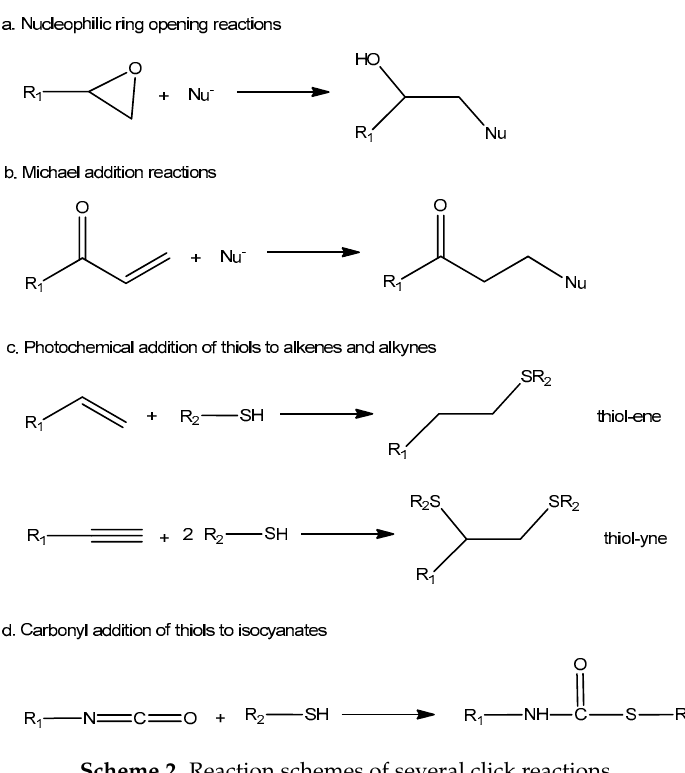
Scheme 2. Reaction schemes of several click